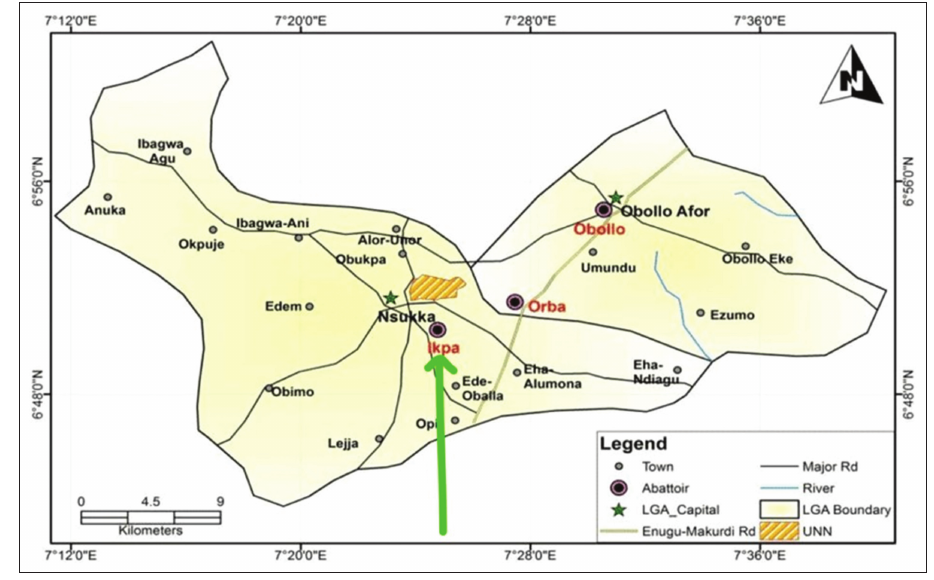
Figure-1: Map of Nsukka urban showing the location of the